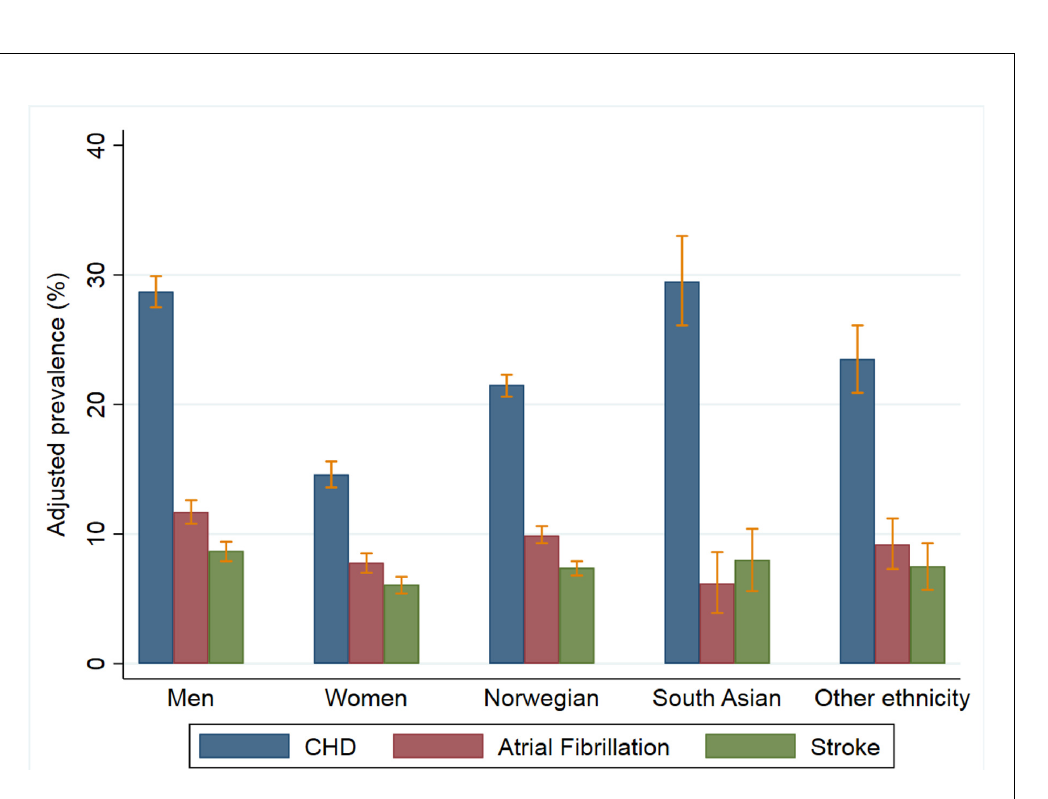
Figure 1. Adjusted prevalence of CHD, atrial fibrillation, and stroke by sex and ethnic group. Numbers for sex are adjusted for age and clustering within practices. Numbers for ethnic group are adjusted for age, sex, and clustering (see Table 1 ). CHD = coronary heart